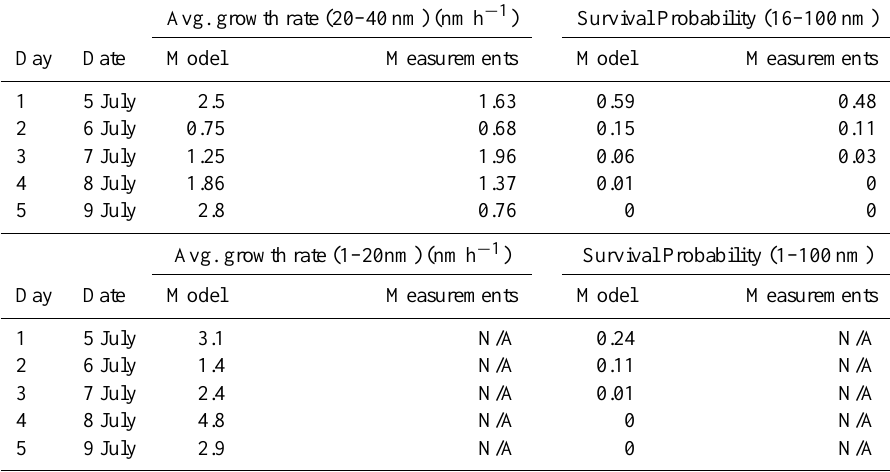
Table 1. Particle growth analysis. Date refers to the day nucleation began. Growth rate and survival probability are calculated from that day through the end of 9 July (unless the nucleation modes grew out of the size ranges given below before the end).